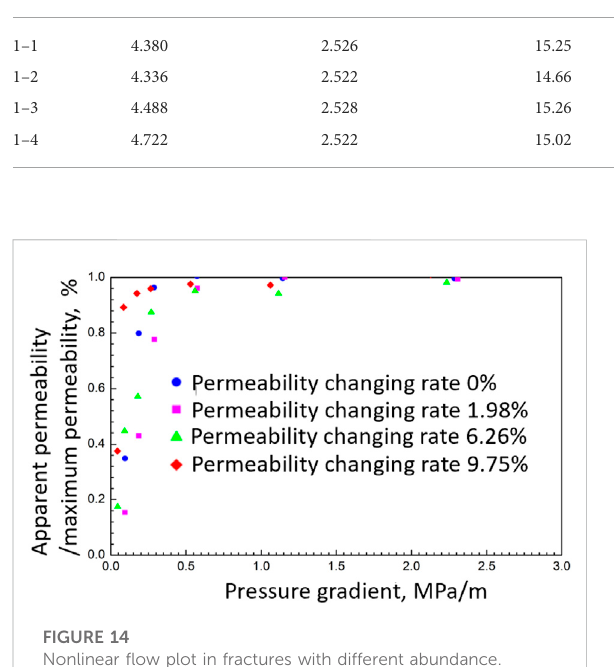
FIGURE 14 Nonlinear fl ow plot in fractures with different abundance.